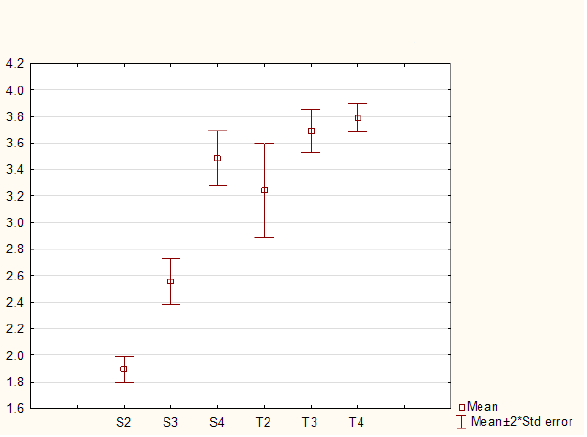
Figure 1: The box and whisker plot obtained for all extracts obtained by Soxhlet and Twisselmann apparatus in different extraction